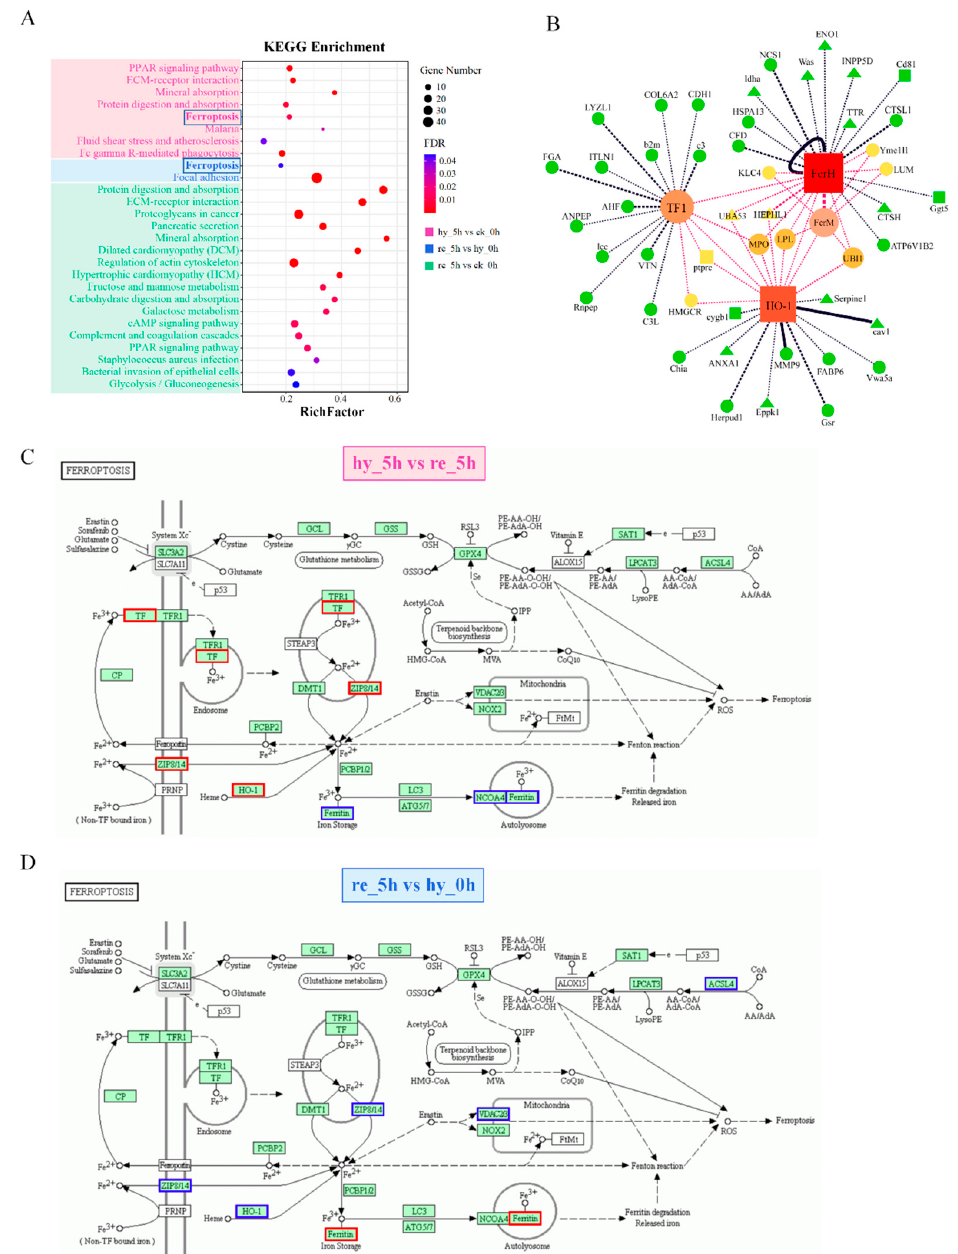
Figure 4. KEGG pathway analysis showing ferroptosis in liver under hypoxia-reoxygenation: ( A ) enriched KEGG pathways of pairwise comparisons in the liver; ( B ) protein–protein interaction (PPI) network shows the interaction between the total DAPs and the DAPs involved in ferroptosis in the liver. Circles represent DAPs between the hypoxia group and the control group, triangles represent DAPs between the reoxygenation group and the hypoxia group, and squares represent the DAPs common to both comparisons. The thicker the line, the higher the correlation coefficient. The larger the dot, the higher the number of proteins in the interaction; a more centrally placed network has a more important or critical function; ( C ) six DAPs between the hypoxia group and the control group were enriched in the ferroptosis pathway; ( D ) five DAPs between the reoxygenation group and the hypoxia group were enriched in the ferroptosis pathway. Blue boxes represent downregulated proteins, and red boxes represent upregulated proteins. DAP, differentially abundant protein; KEGG, Kyoto Encyclopedia of Genes and